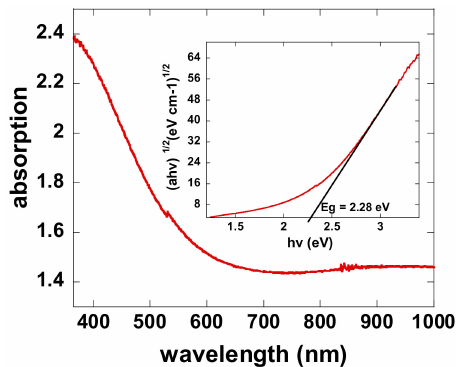
Figure 4. Absorption spectrum of the 40-nm-thick LaB x thin film on quartz glass and the inset shows the plot of ( ah ν ) 1/2 vs. photon